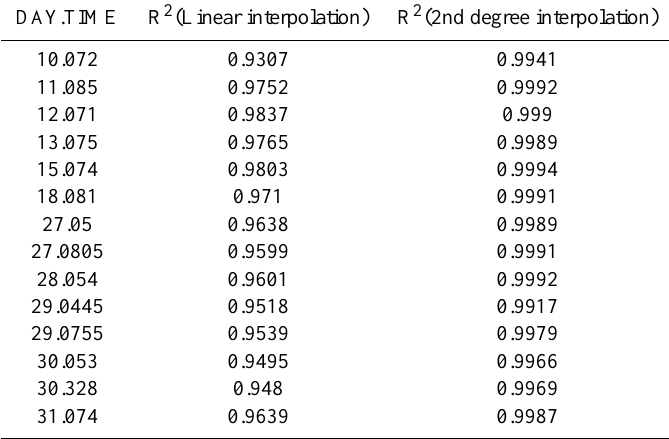
Table 1. R 2 value obtained by linear and 2nd degree interpolation for fourteen points τ aAERONET of January 2004.